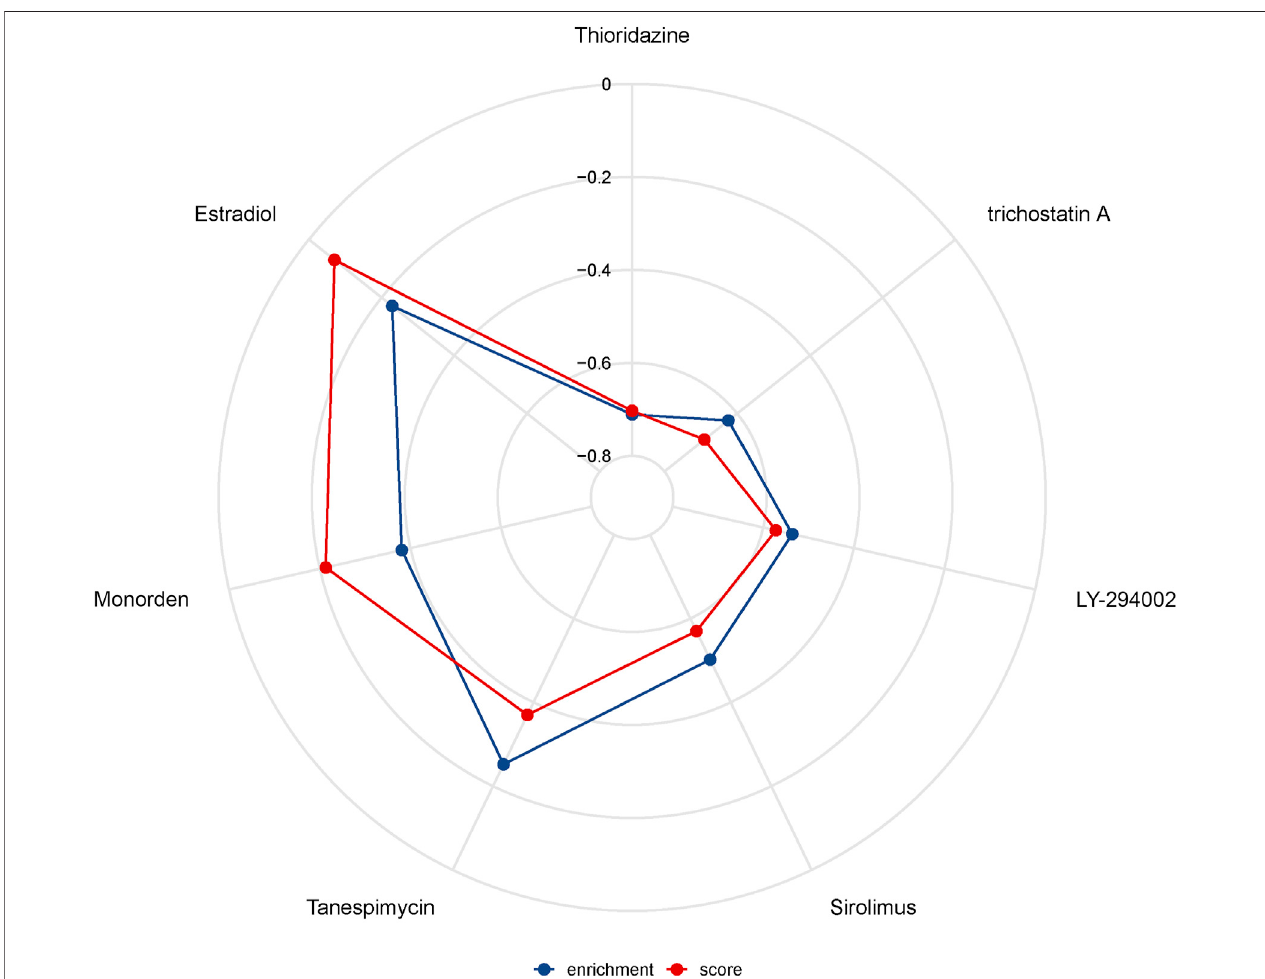
FIGURE 8 | Drug sensitivity